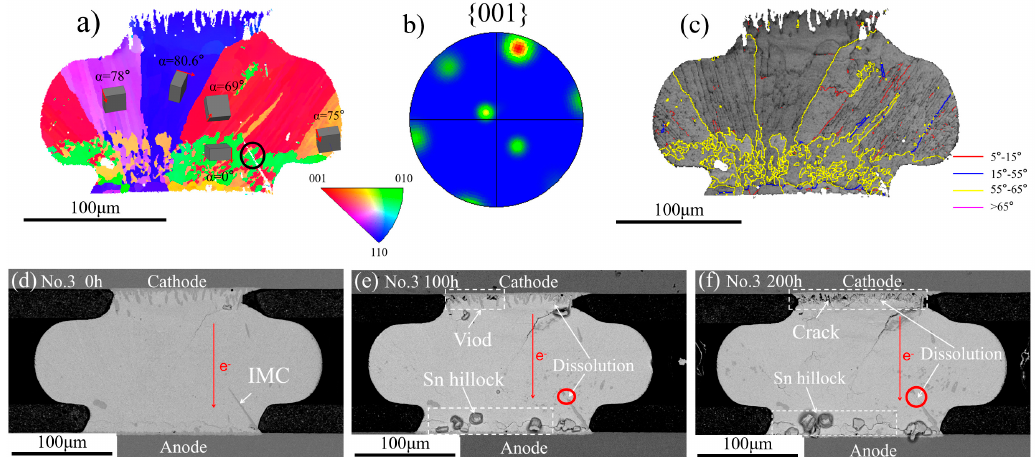
Figure 7. ( a ) EBSD map of the No.3 solder joint after reflow; ( b ) pole figure of {001} plane; ( c ) the grain boundary distribution map; SEM images of the No.3 solder joint after different current stressing times: ( d ) 0 h; ( e ) 100 h; ( f ) 200 h.